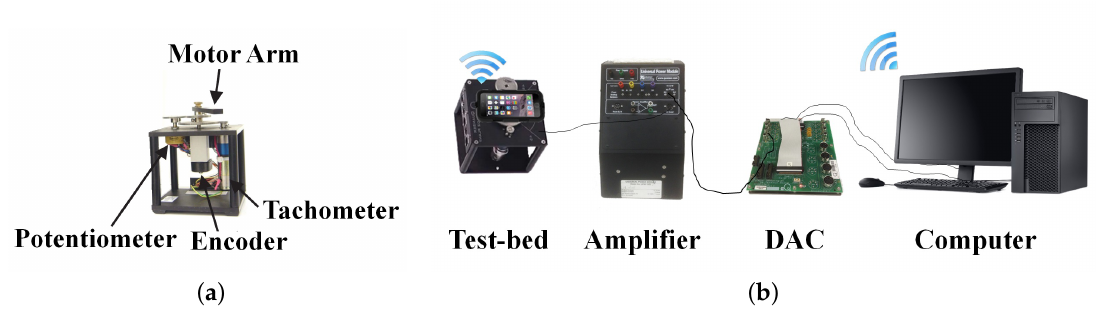
Figure 1. ( a ) DC motor test-bed and ( b ) experimental setup with a PC-based